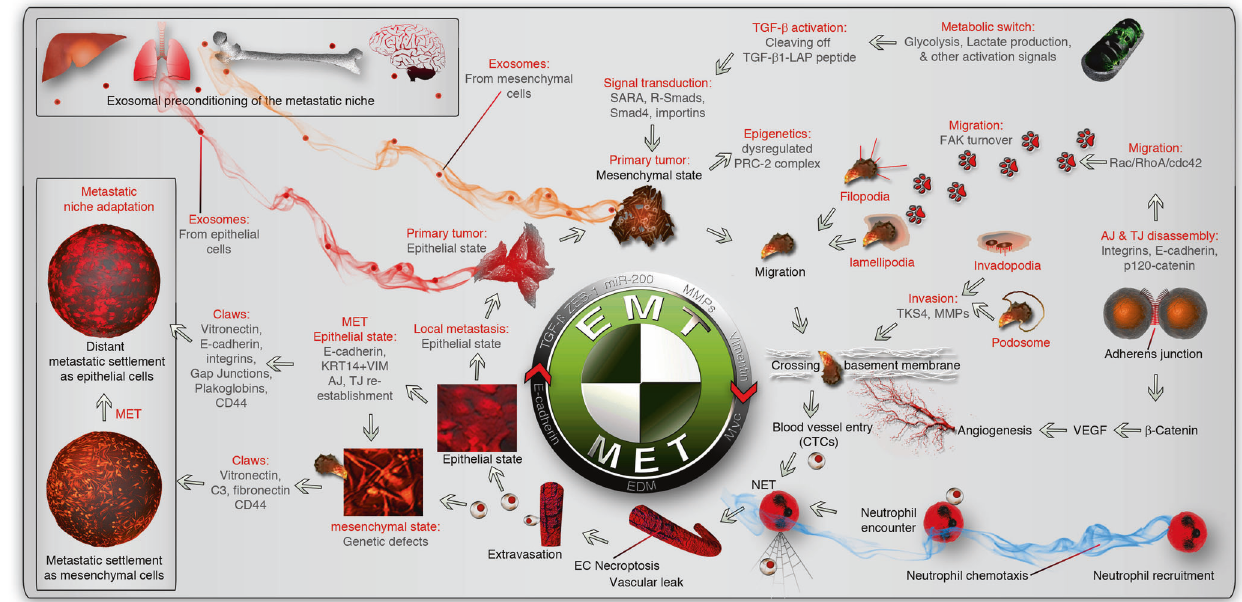
Fig. 1 Classical EMT pathway for metastasis. The metastatic events start with the primary tumor producing exosome-mediated or alternative preconditioning of the metastatic path and niche (indicated by red/orange smoky trail). The metastatic environment is indicated by inset boxes. Altered glycolysis in primary tumor cells or other ECM remodeling triggers TGF- β activation by processing the latency-associate peptide (LAP) to regulate transcription by activation of receptor-regulated Smads-2/3 (R-Smads) through Smad anchor for receptor activation (SARA). Resultant EMT-inducing transcription factors induce a mesenchymal transition from epithelial phenotype while suppressing apoptosis through dysregulated polycomb repressor complex-2 (PRC2). Mesenchymal phenotype is associated with adherens junction (AJ) and tight junction (TJ) disassembly to promote migration (through FAK turnover, lamellipodia, and fi lopodia) and invasion (through invadopodia and podosomes to cross basement membranes) phenotypes to reach the circulation or through promoting local angiogenesis by VEGF. Inside the blood vessel, neutrophils are attracted by chemotaxis (blue smoky trail), which promotes neutrophil extracellular trap (NET) and necroptosis to facilitate vascular exit. This exposes the circulating tumor cells (CTCs) to a new microenvironment which may or may not promote the reversal of EMT (MET) through the promotion of the epithelial differentiation module (EDM). The extravasated cells use different adhesion cues (claws) to settle and adapt to the new metastatic niche. The reversibility of EMT may support another cycle of EMT and